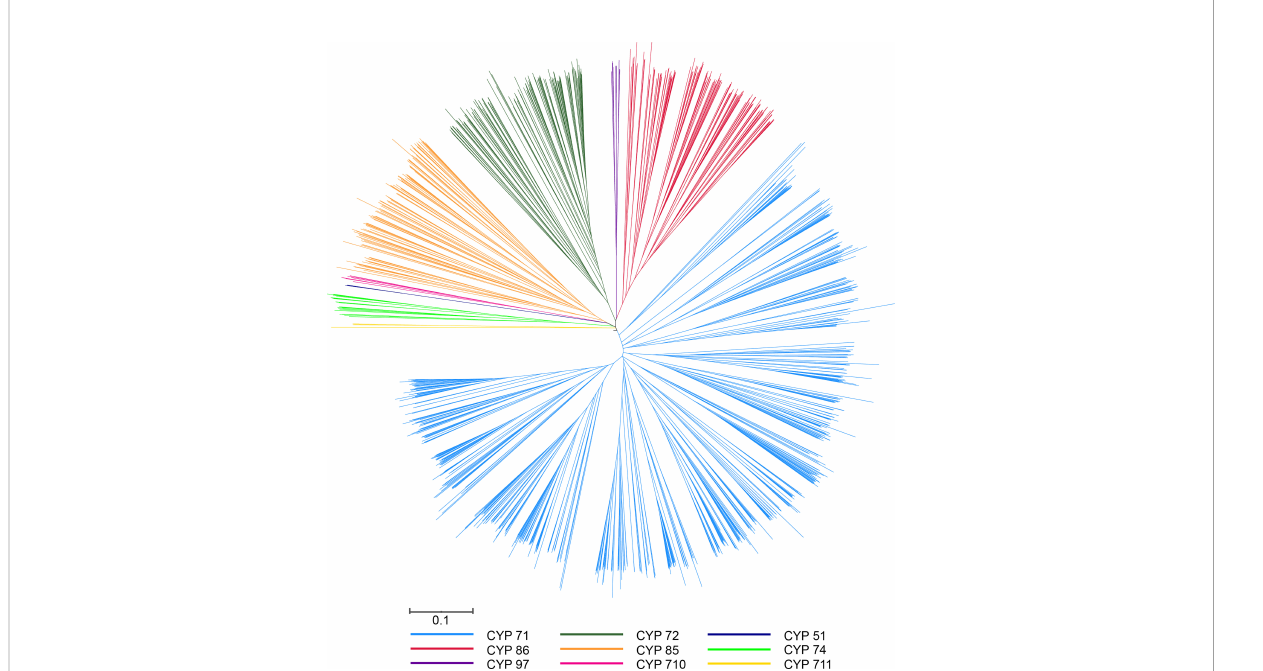
FIGURE 2 Phylogenetic tree of P450 genes from Arabidopsis , pepper, tomato, and potato. The unrooted tree was constructed by MEGA using the neighbor-joining (NJ) method with 1,000 bootstraps. The selected P450 proteins are clustered into nine clans and distinguished by different color